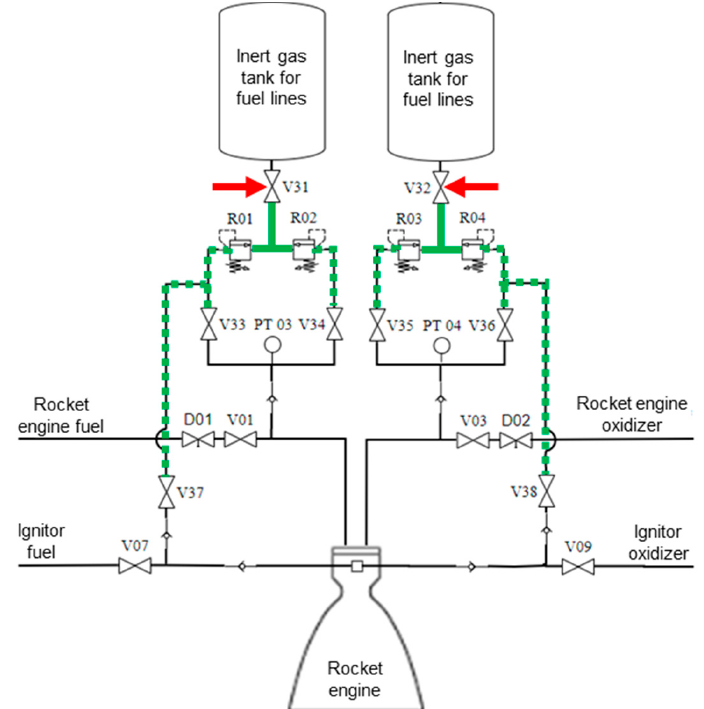
Figure 11. Algorithm’s second step diagram.